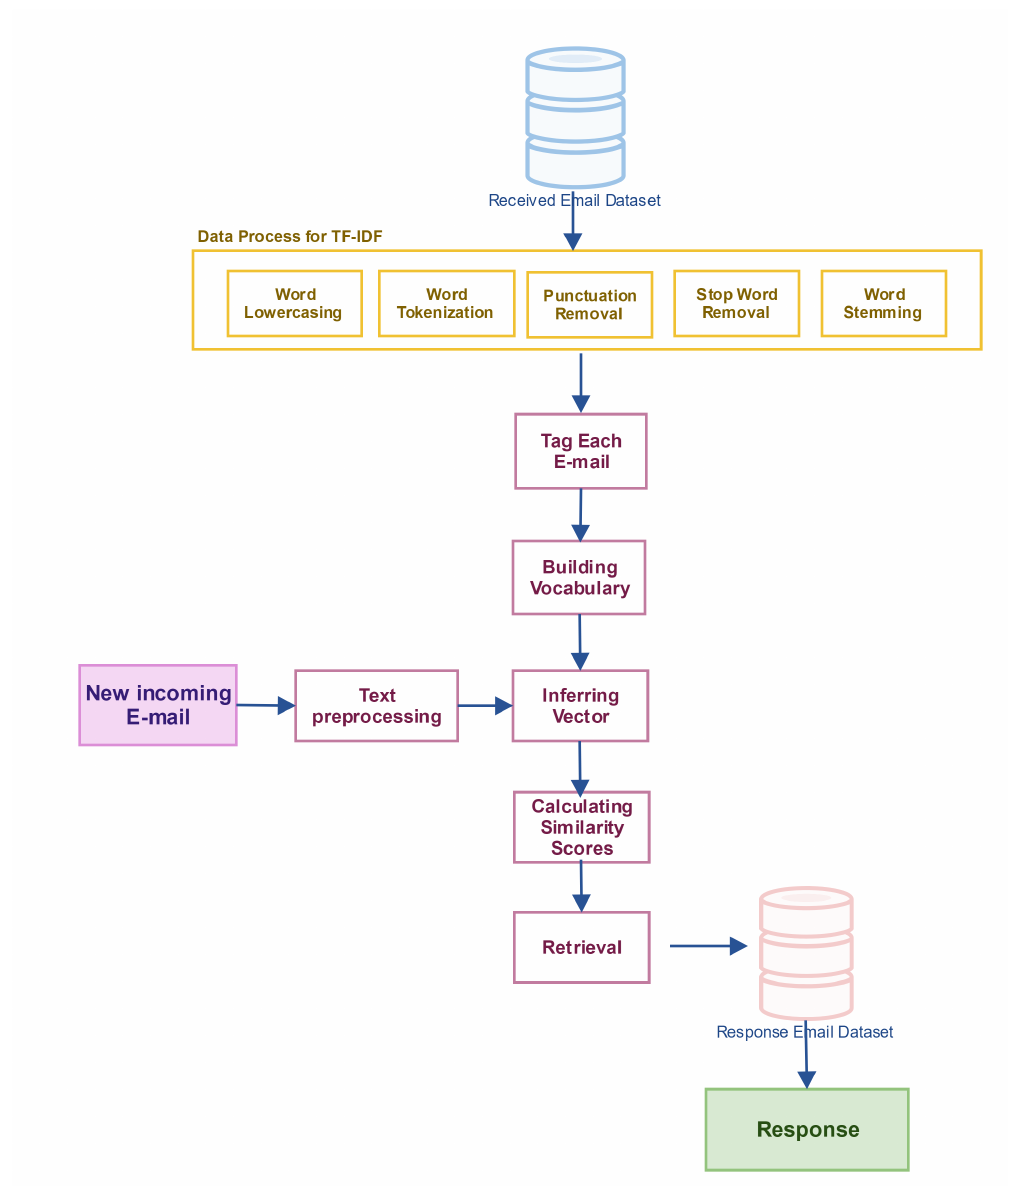
Figure 3. Doc2Vec Based